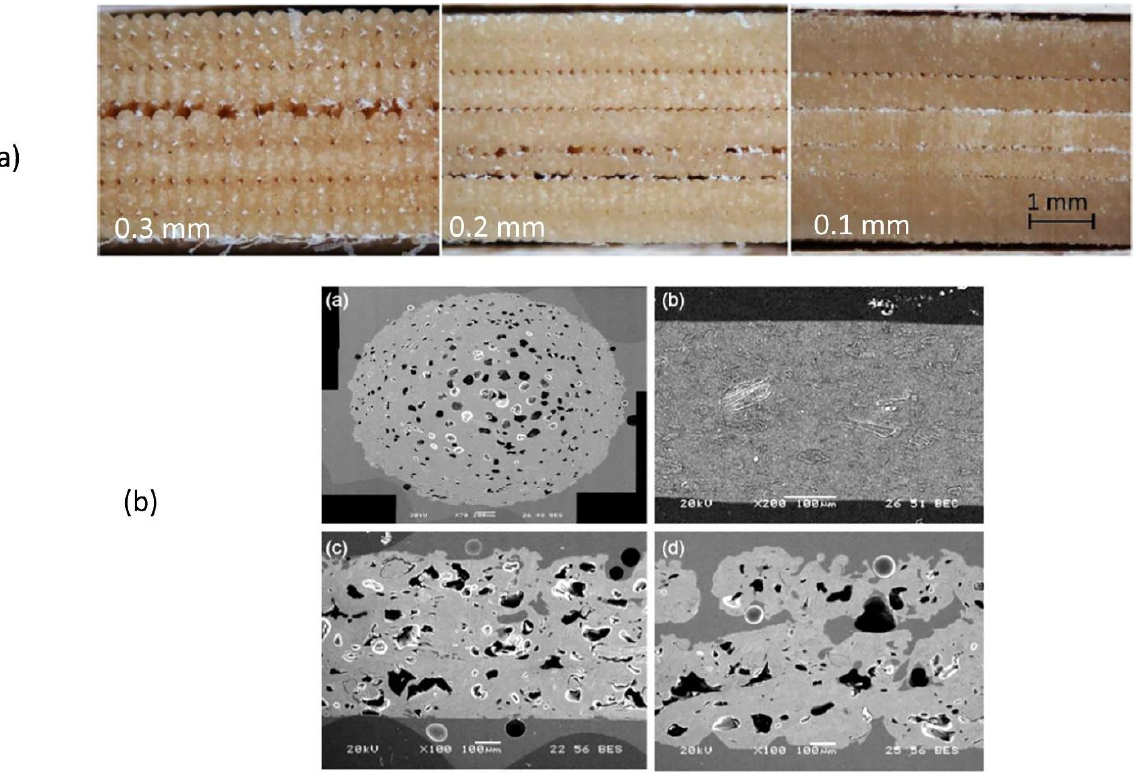
Figure 6. Short natural fibre reinforced PLA. ( a ) Effect of layer height on wood, 0.3, 0.2, and 0.1 mm [126]. Higher porosity content was observed with higher layer height. ( b ) Scanning electron micrograph of printed wood/PLA biocomposites with raw filament cross-section. Adapted from Le Duigou et al. [159] and Ayrilmis et al. [160] with copyright permission of Elsevier.